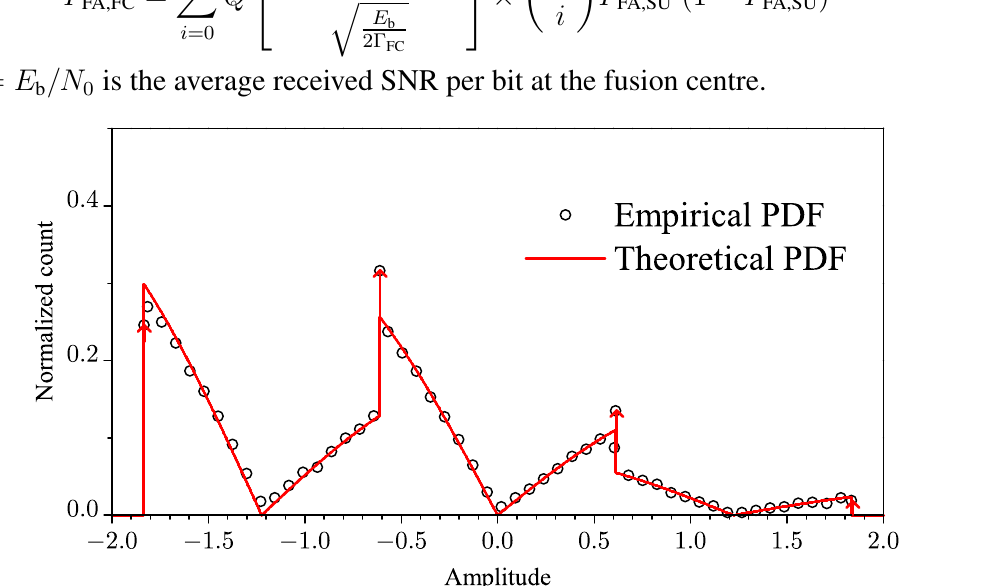
Figure 4. Empirical and theoretical pdfs of the noiseless received symbols from all